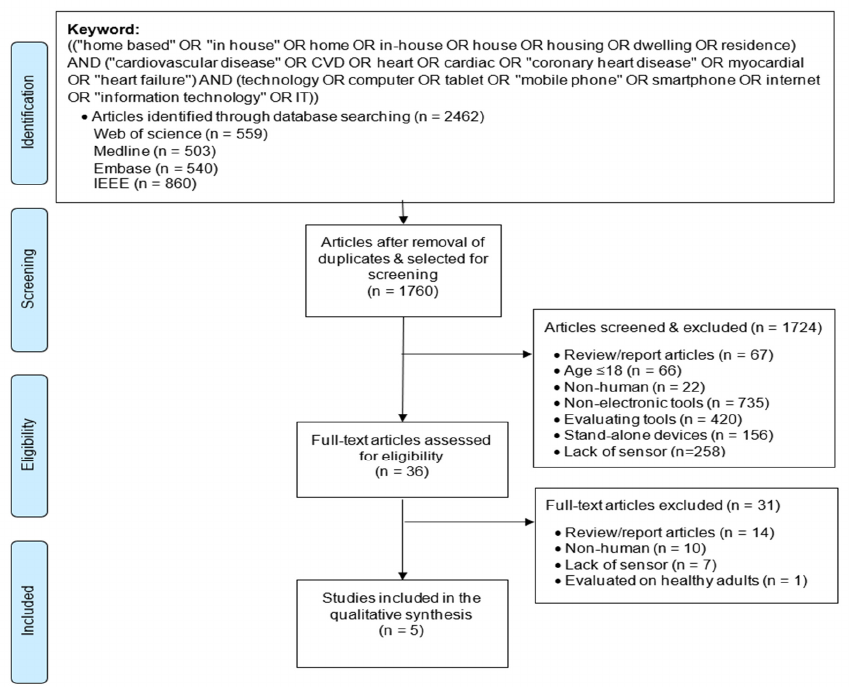
Figure 2. Flow diagram for selection of articles (adapted from reference [30]).